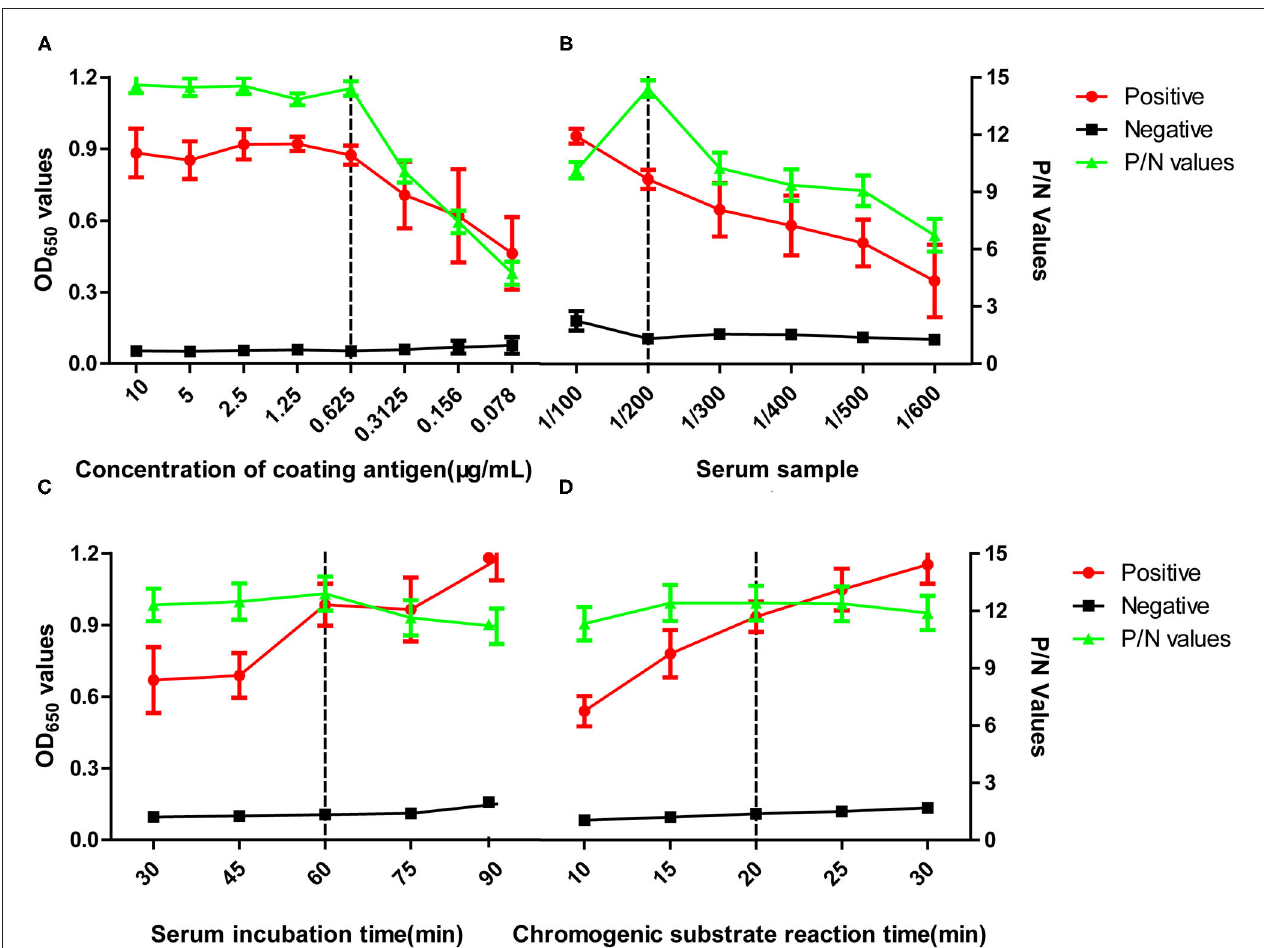
FIGURE 1 | Optimization of pELISA. Assays were performed to optimize (A) concentration of the coating antigen, (B) dilution of the serum sample, (C) incubation time for the serum sample, (D) incubation time for the TMB substrate. The vertical dotted lines indicate conditions selected for using in subsequent assays. OD values shown are the means obtained in three tests of five positive serum samples against M41, H52, CK/CH/2014/FJ14, CK/CH/2014/JT1, or 4/91 or five negative serum samples from SPF chickens. P/N values represent the ratios of mean OD values obtained for positive sera to those obtained for negative sera. Error bars represent the standard deviation